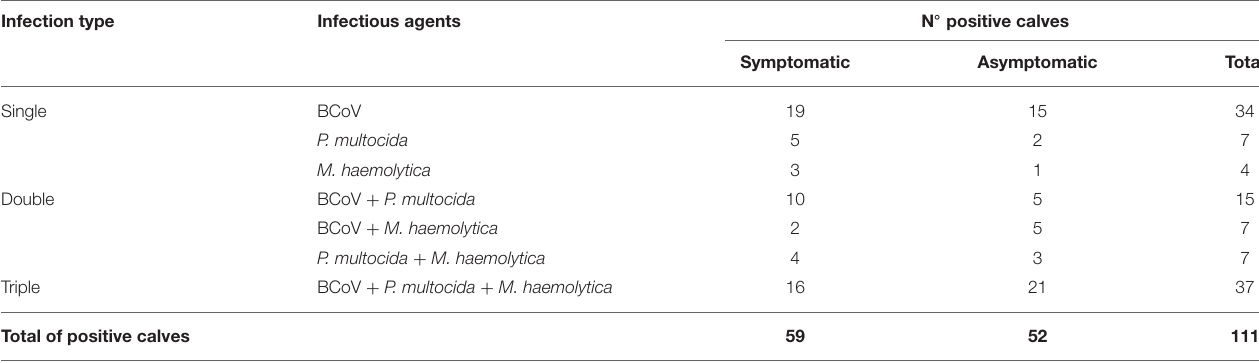
TABLE 3 | Distribution of the infectious agents identified in the upper respiratory tract of heifer calves of dairy cattle herds with bovine respiratory disease according to the type of infection. Infection